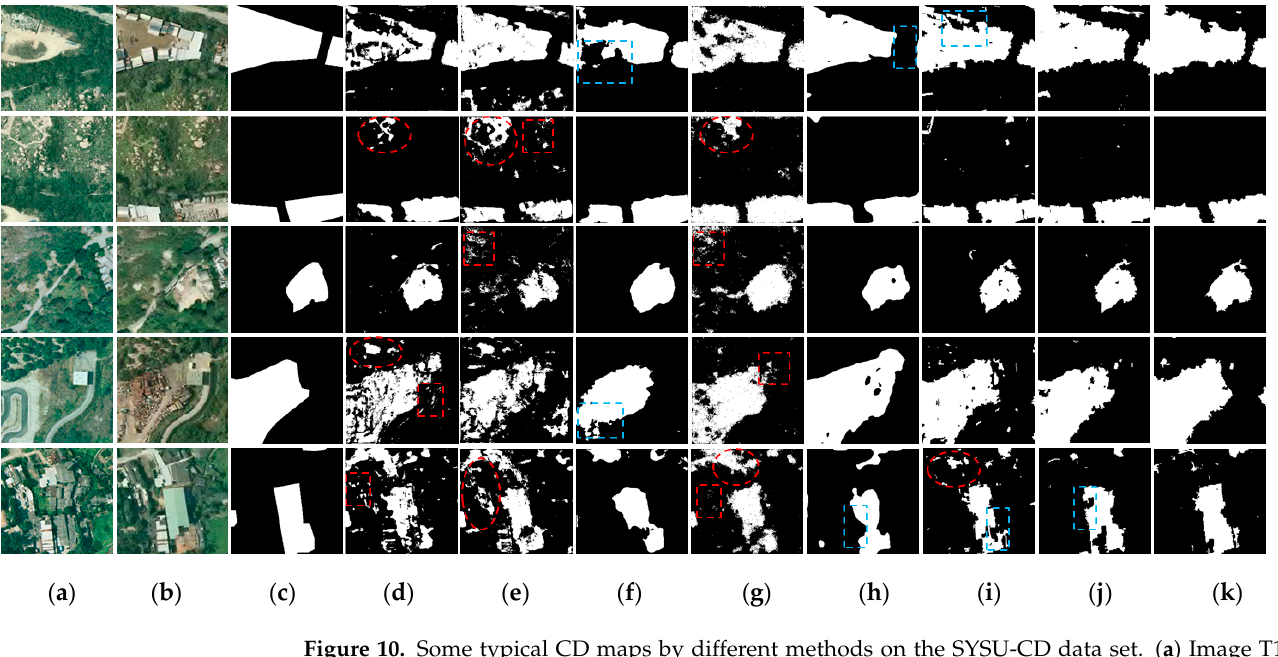
Figure 11. Some typical CD maps by different methods on the WHU-CD data set. ( a ) Image T1. ( b ) Images T2. ( c ) Reference change map. ( d ) FC-Siam-con. ( e ) FC-Siam-diff. ( f ) Siam-NestedUNet. ( g ) DSFIN. ( h ) DSAMNet. ( i ) GCNCD. ( j ) MSGCN. ( k ) DNHGNN.